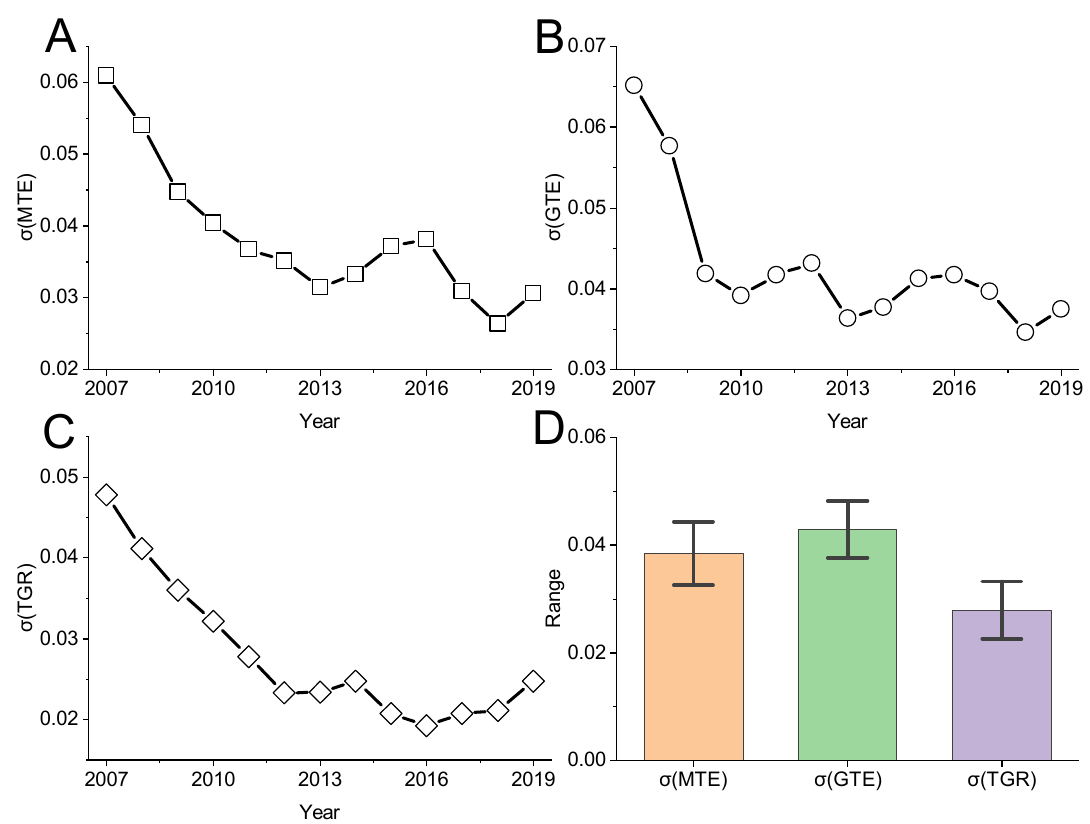
Figure 8. Annual trend of spatial σ convergence and descriptive statistical results. ( A – C ) represent σ convergence of MTE, GTE, TGR respectively. ( D ) represents the mean of σ convergence and its 95% confidence interval.